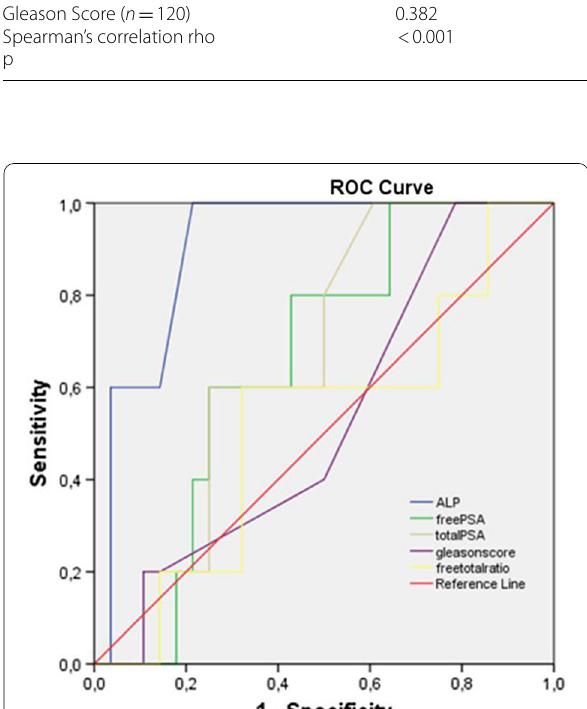
Fig. 2 Receiver-operating characteristic (ROC) curve of sensitivity versus specificity of ALP, free PSA, total PSA, Gleason score, and free/ total PSA in prostate cancer bone metastases